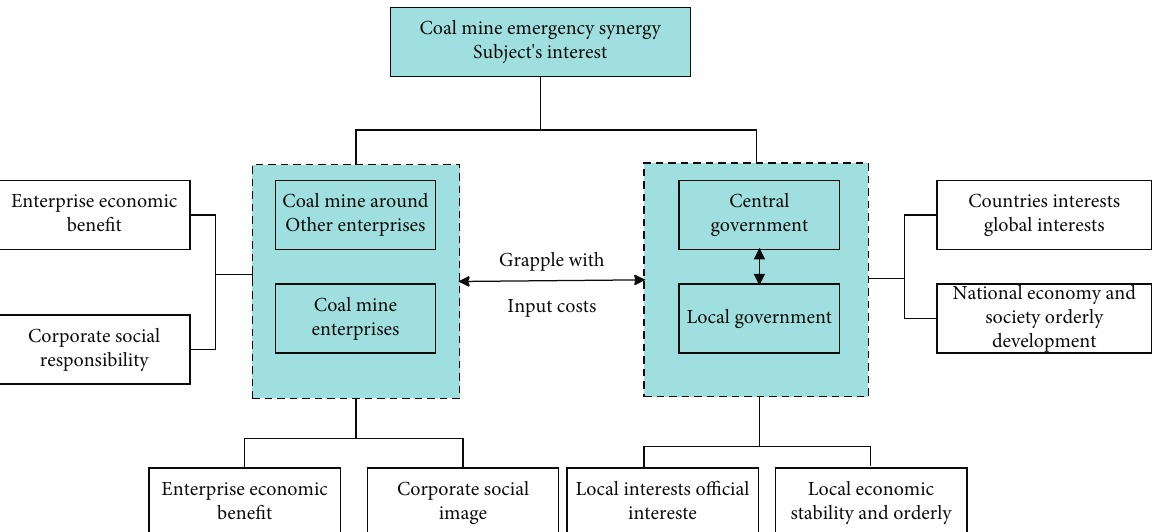
Figure 1: Interest relationship among main subjects in the regional CME management synergy system.